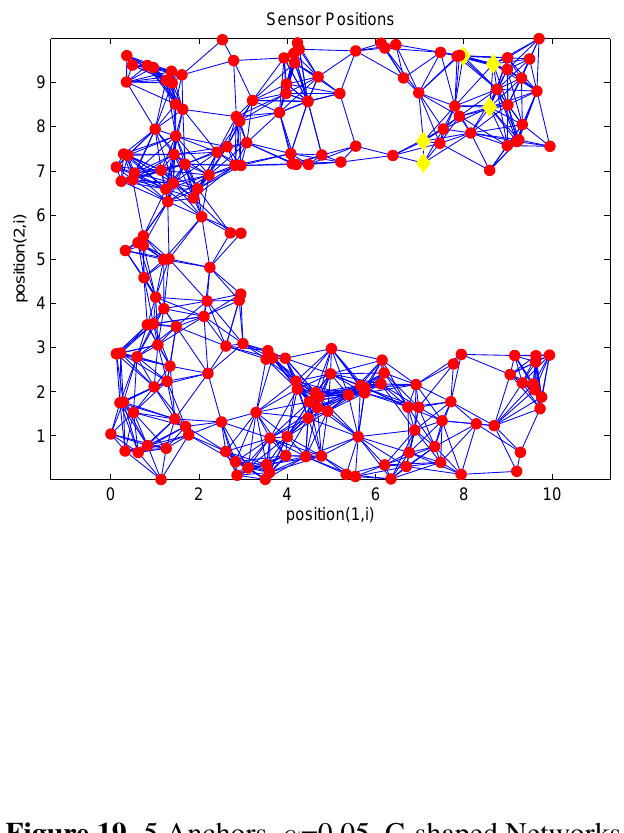
Figure 18 . 5 Anchors clustered at the tip of ‘C’.